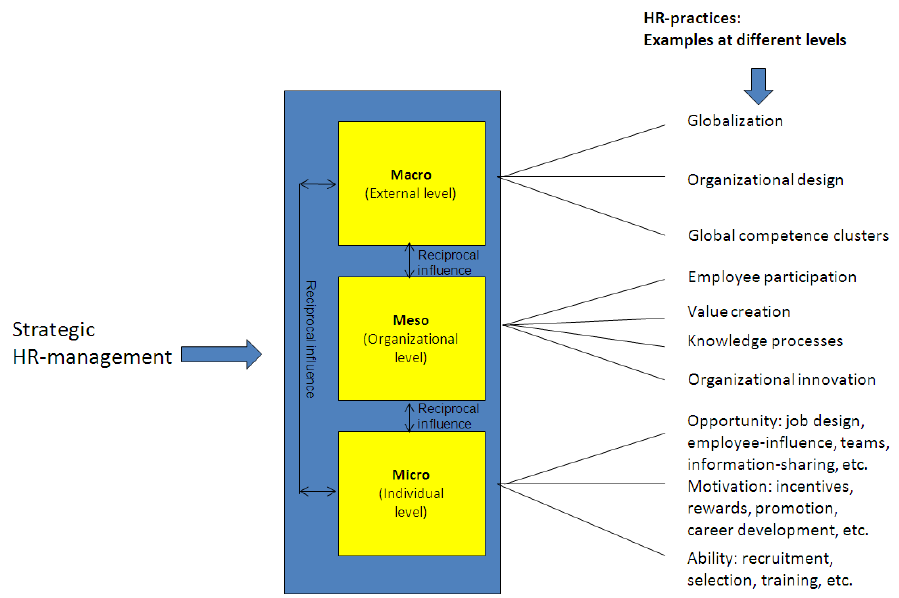
Fig. 1. Strategic HR management – an analytical